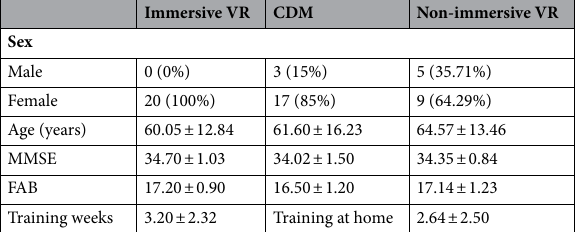
Table 1. Baseline characteristics of the intention-to-treat population (summarizes mean, SD and, percentages (%)). MMSE mini mental state examination, FAB frontal assessment